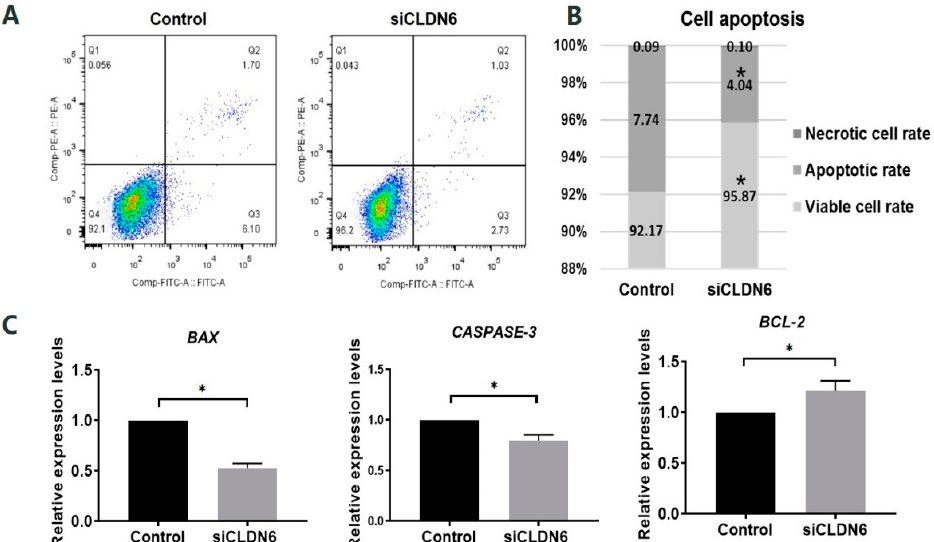
Figure 4. Apoptosis assay of bovine CCs with CLDN6 knockdown. ( A ) CCs transfected with siCLDN6 or siNC were stained with Annexin V-FITC and PI. The percentages of apoptotic cells were detected by flow cytometry. Q1 refers to necrotic cells, Q2 refers to late apoptotic cells, Q3 refers to early apoptotic cells, Q4 refers to viable cells; ( B ) Differences in apoptosis rate, viable cells rate and necrotic cells rate of CCs transfected with siCLDN6 or siNC were shown; ( C ) The mRNA levels of BAX , CASPASE-3 and BCL-2 genes in CCs transfected with siCLDN6 or siNC. Control group was the cells transfected with siNC. * p < 0.05.